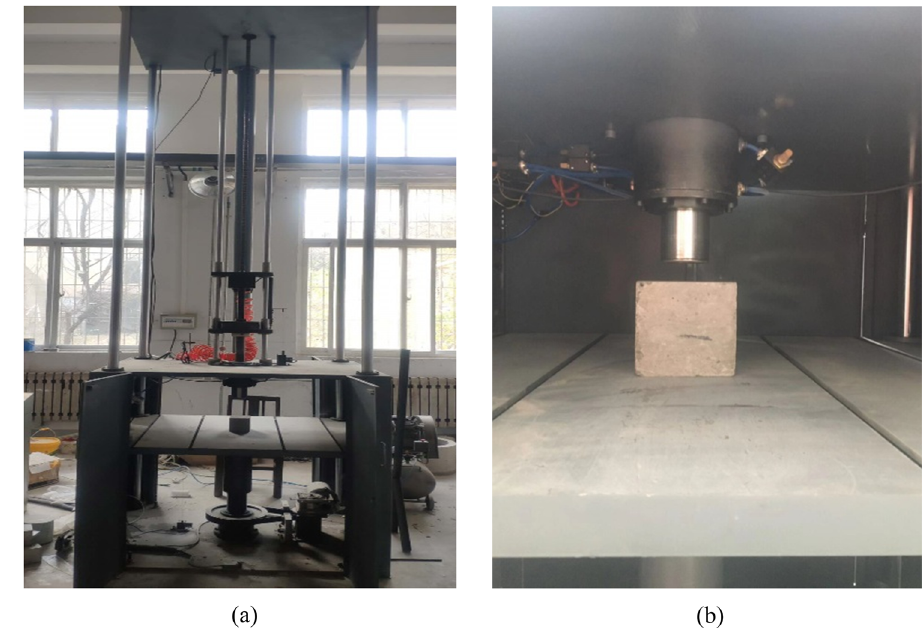
Figure 4: Impact testing apparatus: ( a ) impact testing machine and ( b ) impact testing specimen.